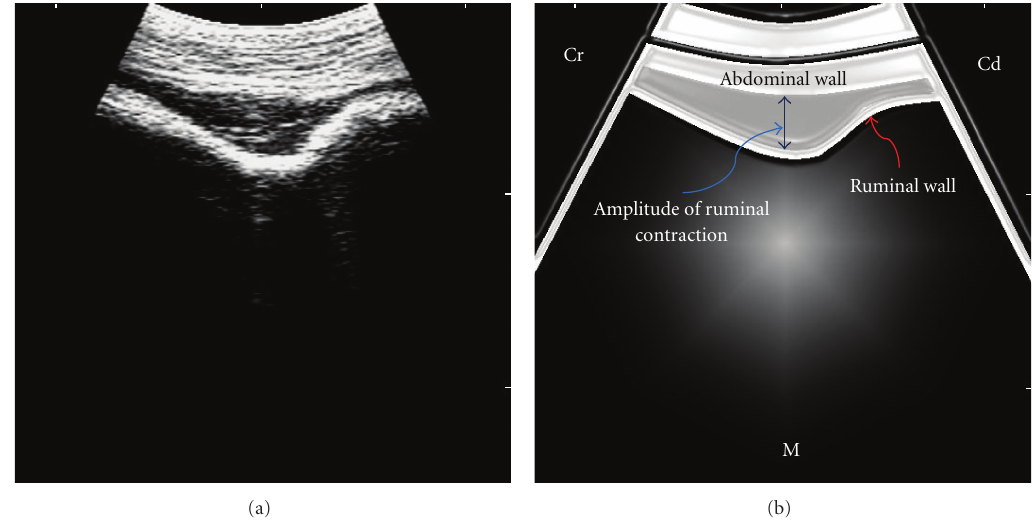
Figure 2: Ultrasonogram of the rumen obtained from left mid-paralumbar fossa at the peak of its contraction, by placing the transducer parallel to the longitudinal axis of the cow. Cr: cranial, Cd: caudal, and M: